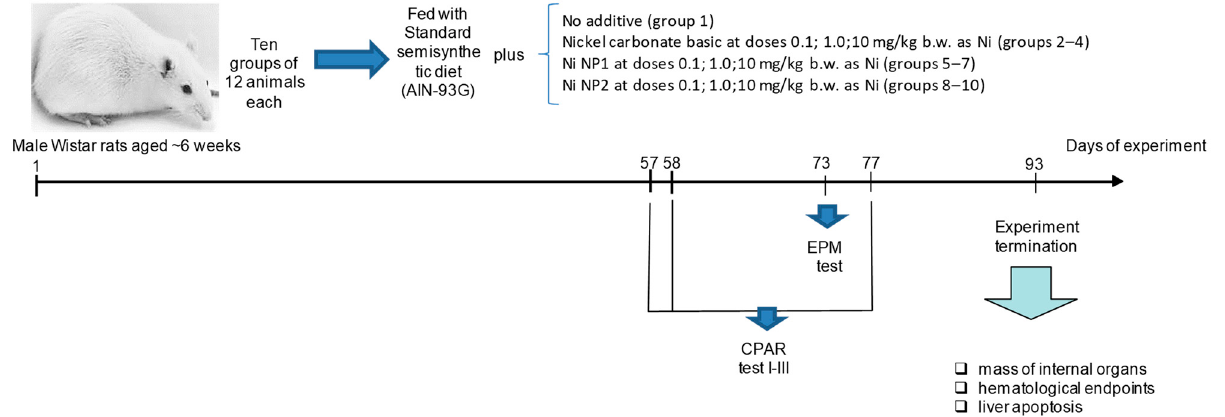
Figure 1. Schematic representation of the experimental design of subchronic toxicity study.